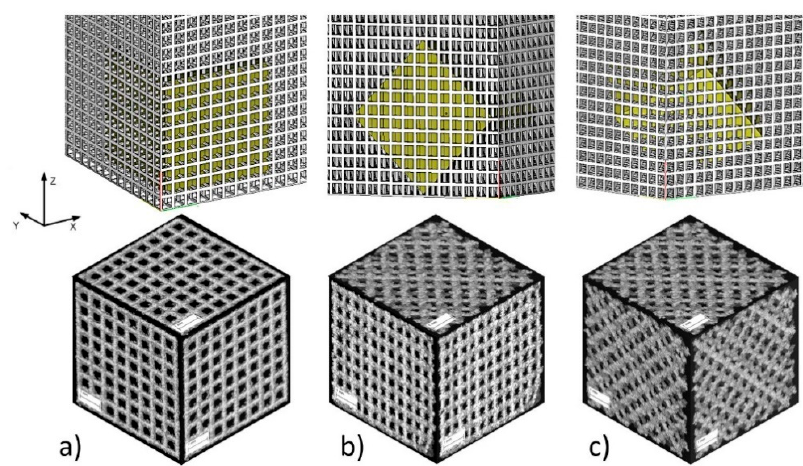
Figure 2. BFS specimen types: ( a ) type A—specimen structure without rotation with perpendicular struts in each plane; ( b ) type B—structure rotated 45° with respect to one axis; ( c ) type C—structure rotated 45° with respect to two axes.